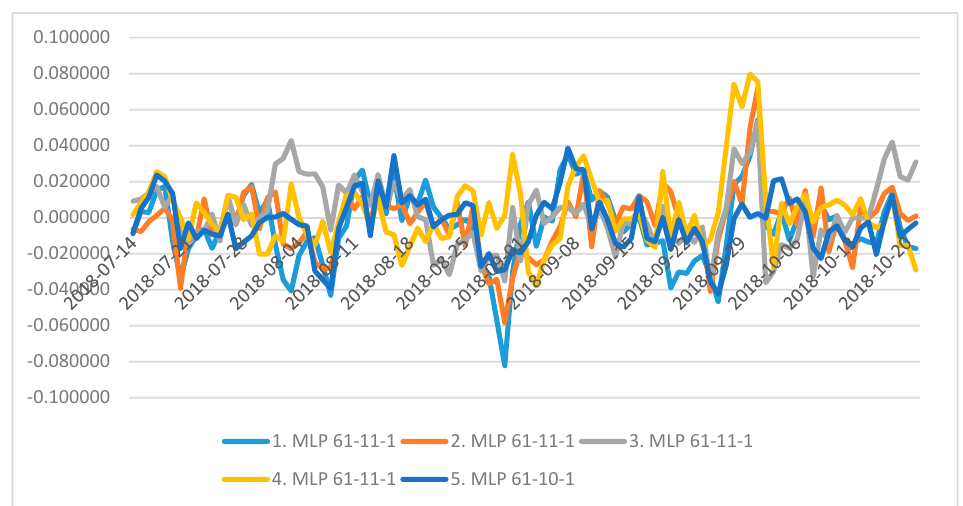
Figure 8. Development of residuals for the equalized time series during the period from 14 July to 21 October (Source: Own research).